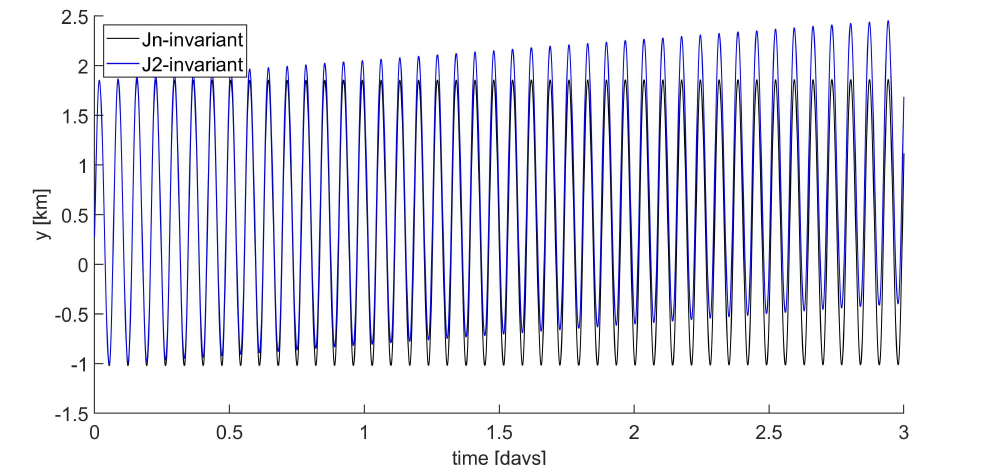
Figure 10. Mid-inclination eccentric LEO formation: time behavior of y component for J n -invariant and J 2 -invariant initial